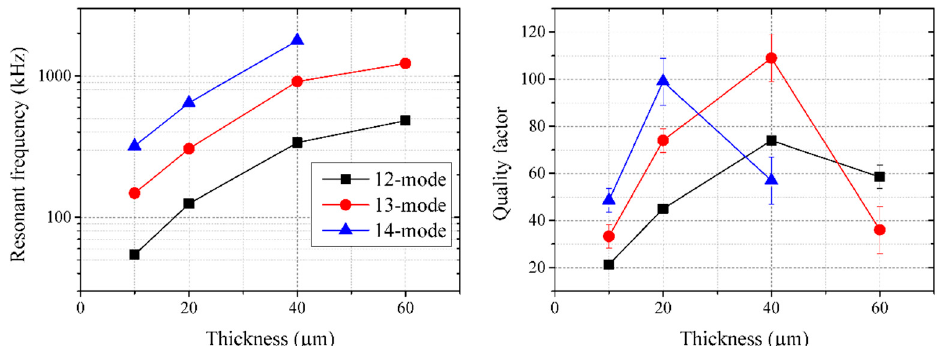
Figure 8. Resonant frequencies and quality factors for the first three roof tile-shaped modes in cantilevers with different thickness and constant length and width of 1500 µm and 900 µm, respectively.